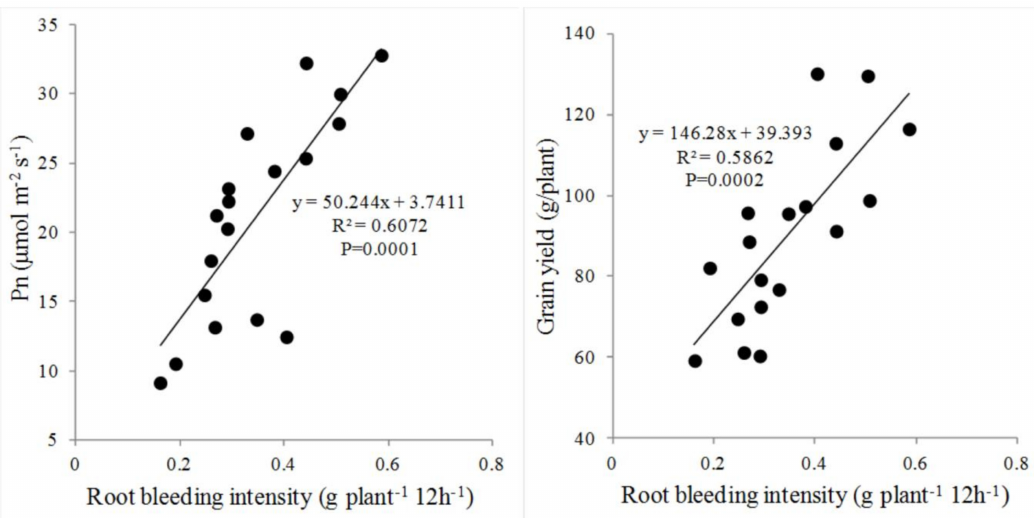
Figure 6. The correlation between root bleeding intensity and grain yield, Pn (net photosynthetic rate). The data was from two cultivars and included every treatment and replicates; p < 0.01 represents extremely significant